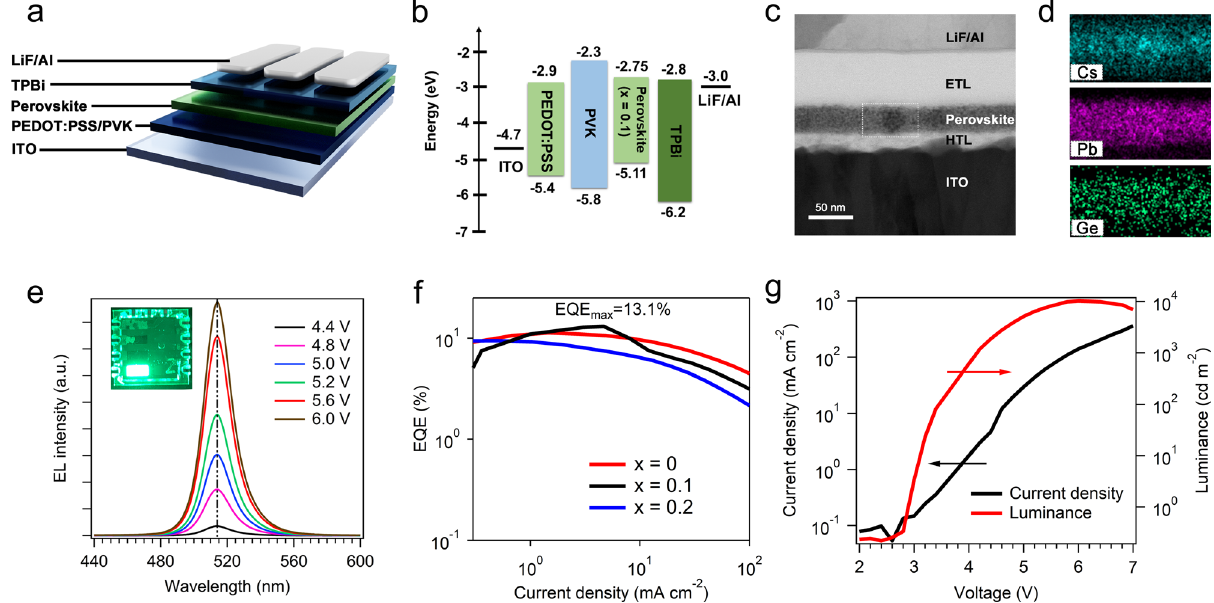
Fig. 3 Characterization of Ge – Pb PeLED performance. a Schematic of the Ge – Pb PeLED device structure. b Flat-band energy level diagram of a Ge – Pb PeLED. c A STEM-HAADF image of the cross-section of a Ge – Pb PeLED. d EDS elemental maps of Cs, Pb, and Ge in the same area enclosed by the dashed box in ( c ). e The EL spectra across a range of operating voltages. Inset: a photograph of a working Ge – Pb PeLED. f EQE-current density curves for PeLEDs with 0 mol%, 10 mol%, and 20 mol% Ge inclusion. g Current density-luminance-voltage characteristics of the best-performing PeLED with 10 mol% Ge